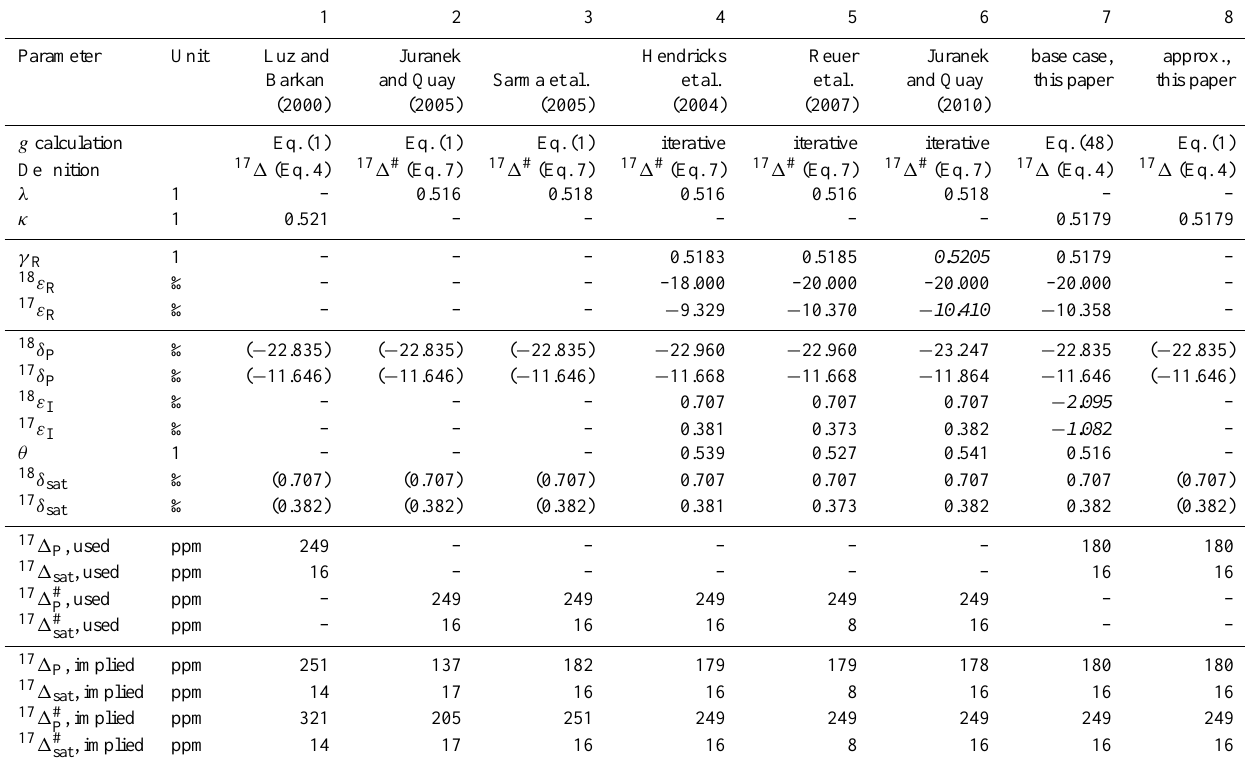
Table 3. Comparison between different calculation methods for g . A dash (–) or values in brackets mean that the corresponding parameters are not used in the calculation. The “used” 17 O excess values are used by the different calculation methods. The “implied” 17 O excess values are calculated using the definitions adopted by the different calculation methods, based on the listed 17 δ P , 18 δ P , 17 δ sat and 18 δ sat values. Where the calculation method does not require these δ values, the values for the “best case” in Table 2 have been used for the “implied” 17 O